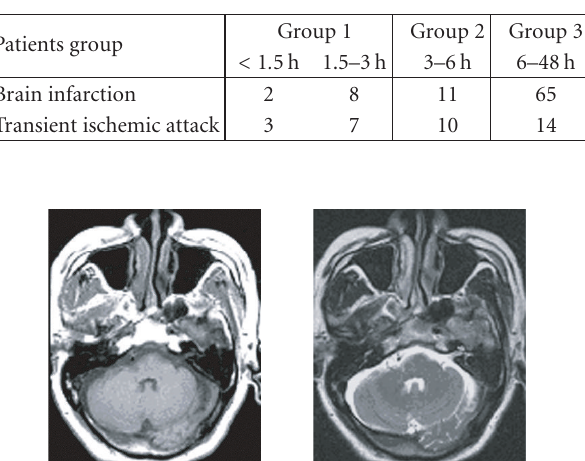
Table 1: Patient groups according to time from stroke onset to be- ing treated.